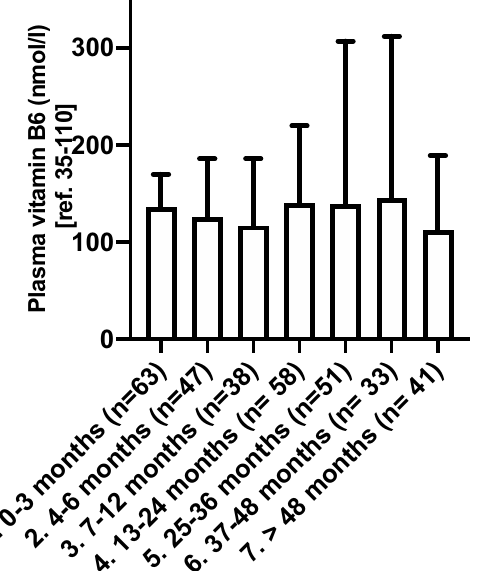
Figure 2. Plasma vitamin B6 levels according to postoperative time interval from last bariatric surgery procedure. Vitamin B6 plasma levels at different time points after the last bariatric surgery procedure. Data are presented as median plasma levels and interquartile range. There was no significant difference between the groups. n number of vitamin B6 measurements in 205 patients in